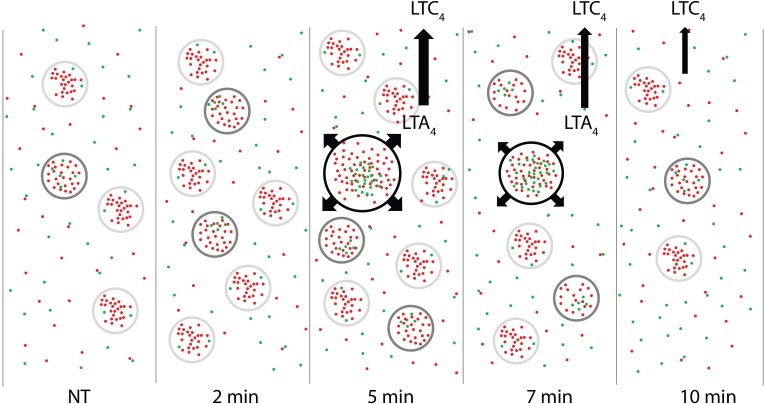
Proposed model linking HIC to LTC4 synthesis.At steady state (NT), small clusters (NIC, light gray outline) of 5-LO (green) or FLAP (red) exist on the nuclear membrane, few with 5-LO associated with FLAP (LIC, dark gray outline). By 2 min after activation, 5-LO and FLAP increasingly interact and more LIC are observed. Between 5 and 7 min after activation, large clusters with extensive interaction between 5-LO and FLAP have formed (HIC, black outline) and produce LTA4, which is converted to LTC4 then released from the cell. HIC are no longer observed at 10 min.